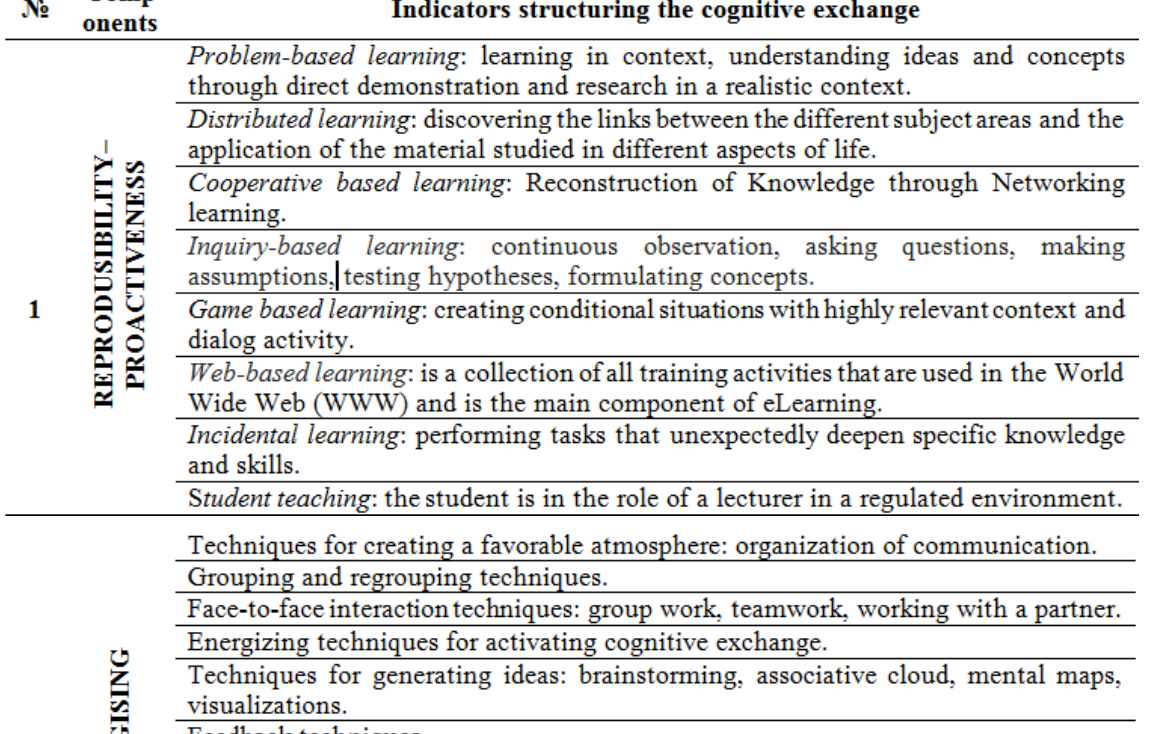
Table 1. Content of the educational environment and indicators, structuring the cognitive